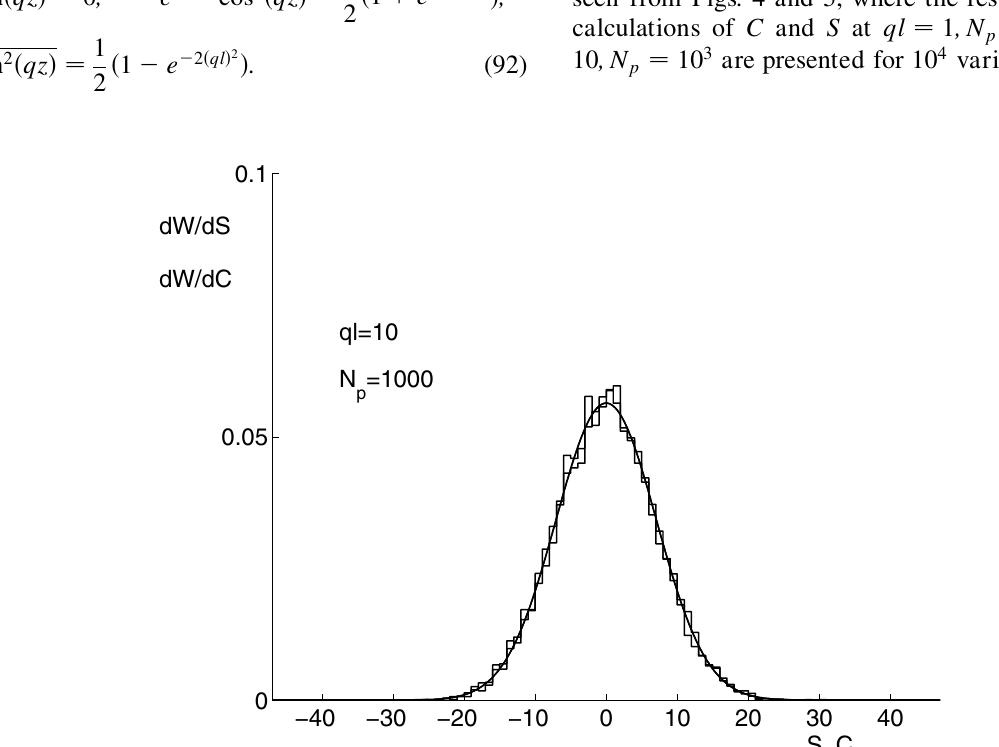
(cid:7) 10 3 (in this case the curves s and c practically coincide). p